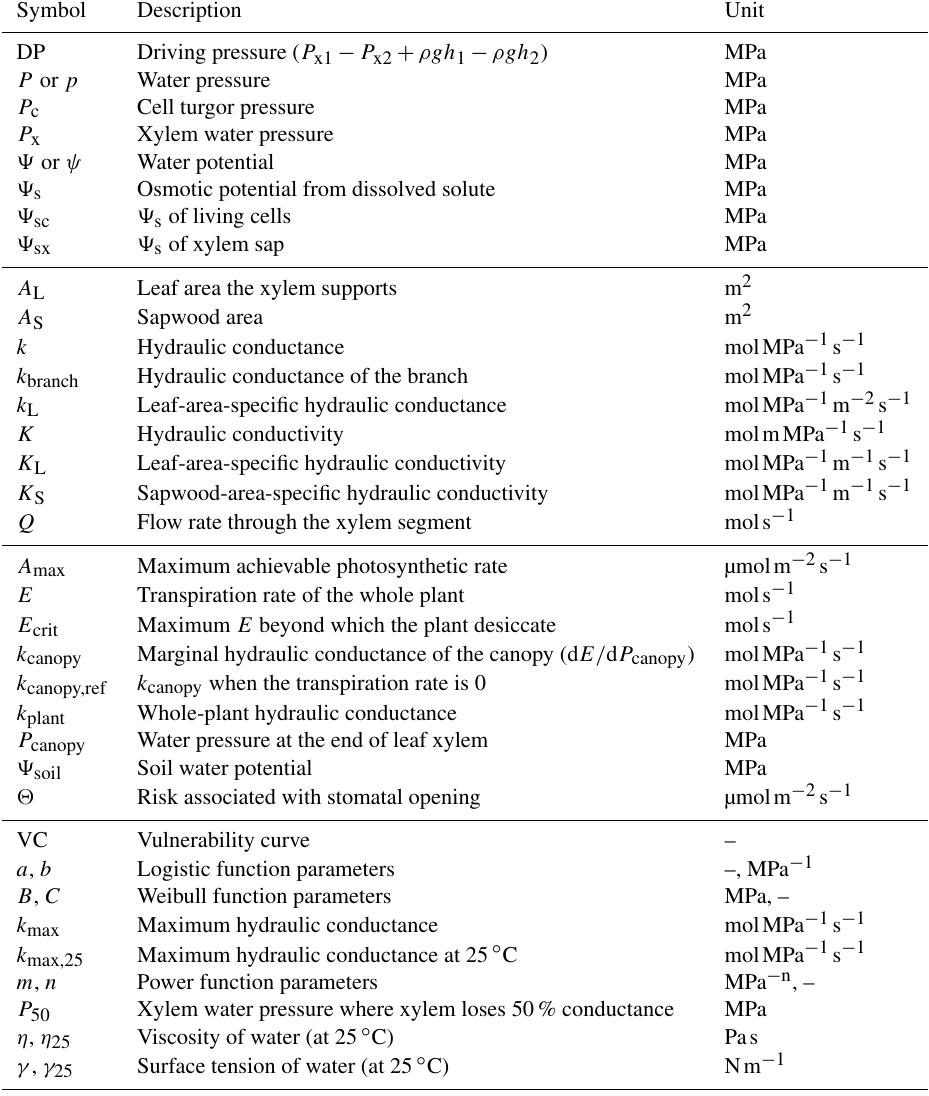
Table 1. List of symbols. Symbol